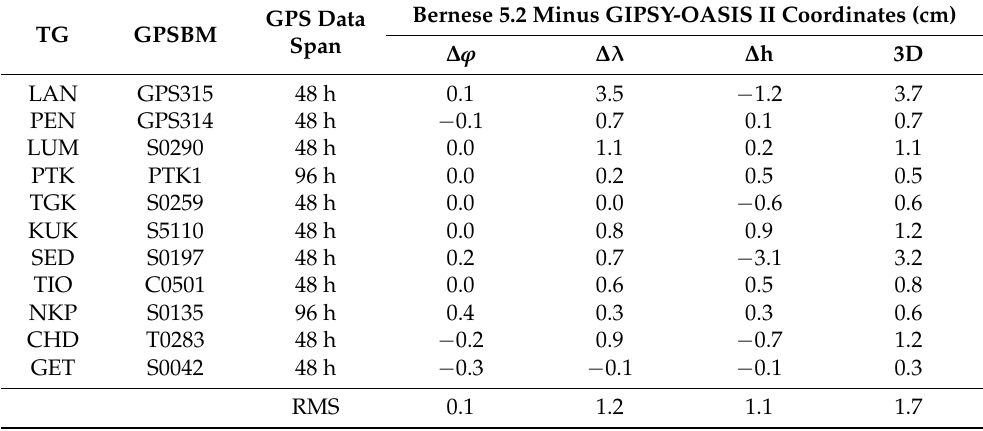
Table 2. Differences in ITRF201414/WGS84 geodetic coordinates at TG-GPSBM sites from AUSPOS (Bernese ver. 5.2) and GIPSY-OASIS II solutions (observation period: August–September 2019).